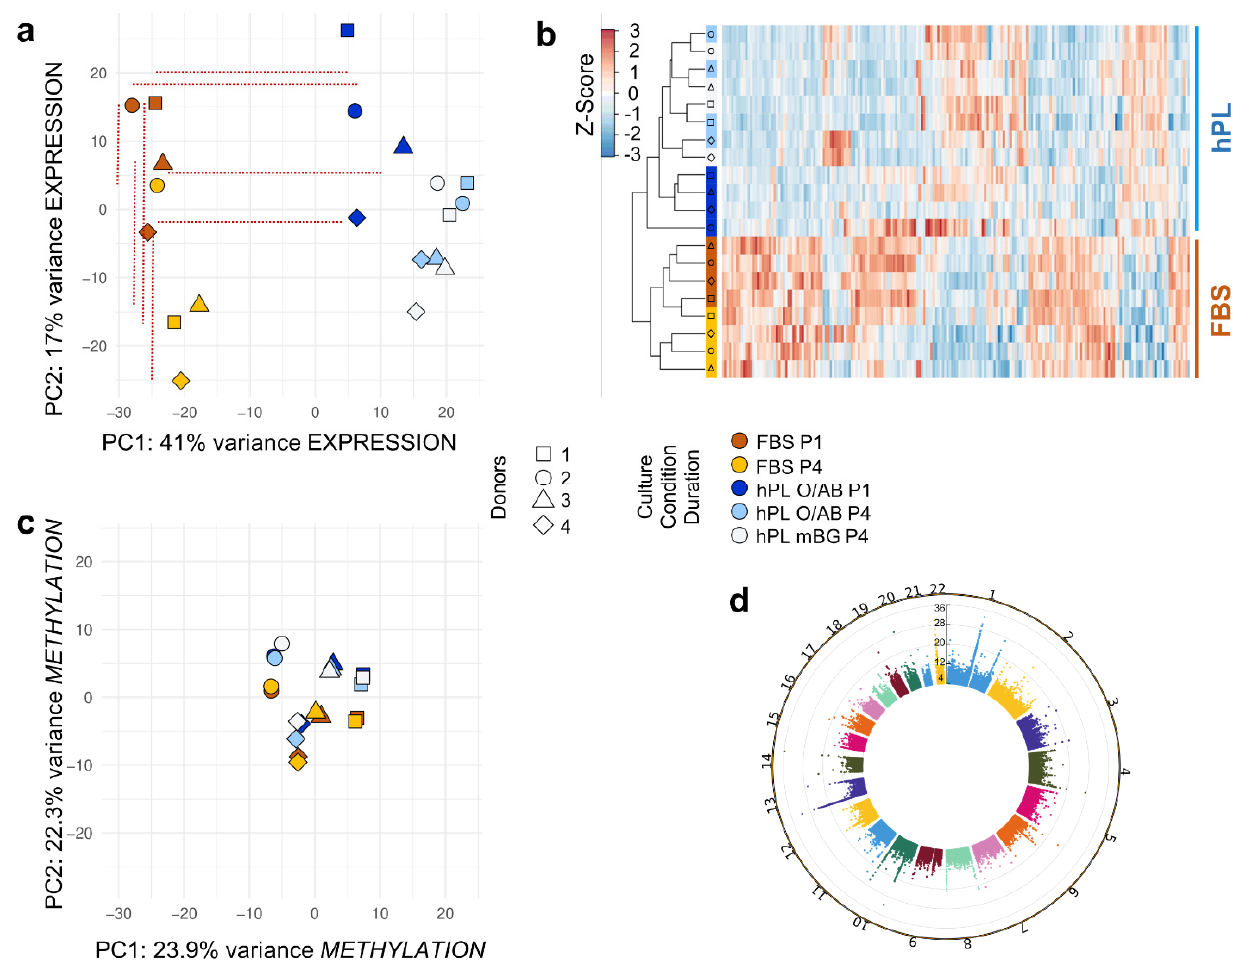
Figure 2. Batch effects on culture-expanded BMSC transcriptomics (( a ) + ( b )) and methylomics (( c ) + ( d )): ( a ) Principal component analysis (PCA) showing the spatial clustering of the different samples (FBS, ocher shades; hPL, blue shades; P1, darker color; P4, lighter colors; hPL mBG open symbols) and different donors (symbols as indicated; color code and symbol legend for a – c ). The culture conditions (hPL-vs. FBS-supplemented) explained most of the variance in the dataset (PC1, 41%). Horizontal red dotted lines highlight the distance of samples from the same donor cultured with FBS (left) vs. hPL (right). PC2 separated samples due to culture duration and donor variation. Vertical dotted lines highlight distance between P1 and P4, regardless of donor variation. ( b ) Heatmap with expression values of top 100 most variable genes (see Figure A4). Samples in rows as indicated and genes in columns; different batch-defining serum supplements and passages in the general color code. Gene expression values were column Z-score normalized; lower expression blue and higher expression red color as shown in the legend. ( c ) PCA of differentially methylated regions with PC1 covering 23.9% and PC2 22.3% of differences. Color and symbol code as indicated. ( d ) Differentially methylated regions were depicted as dots on the Manhattan plot for all autosomal chromosomes. The dot height corresponds to the level of significance with higher dots indicating higher significance, i.e., lower p -value (-Log10 adjusted p -values).